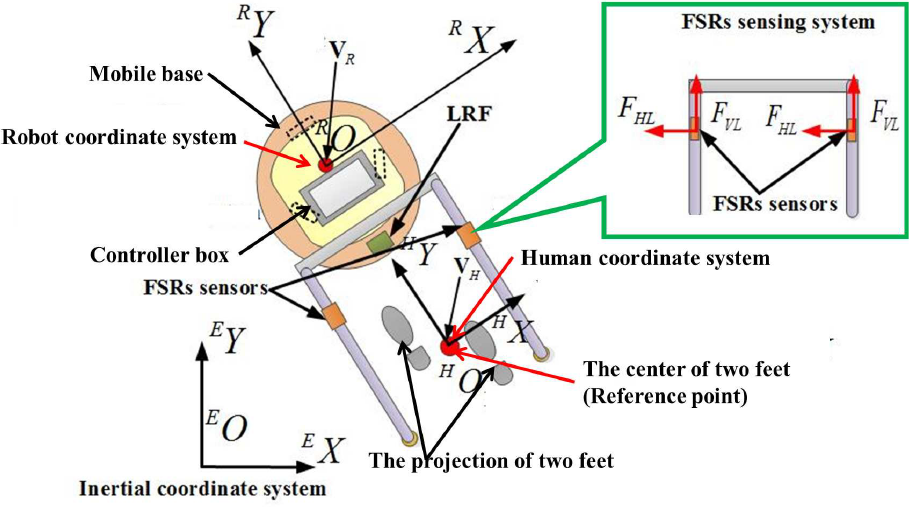
Figure 2. The walking-aid robot coordinate system (top